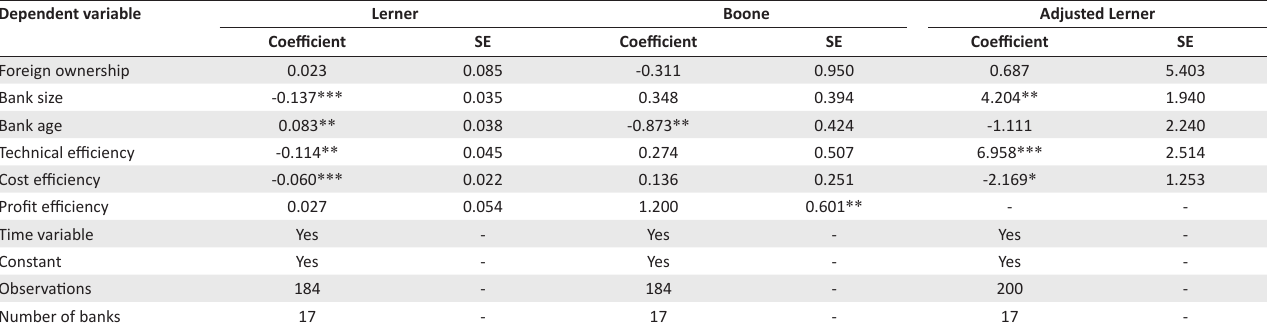
TABLE 1-A1: Competition results.